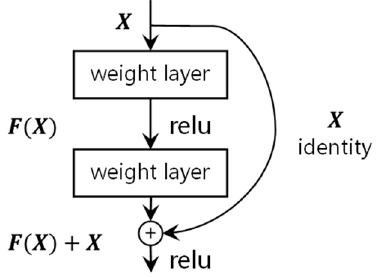
Figure 2. Residual block